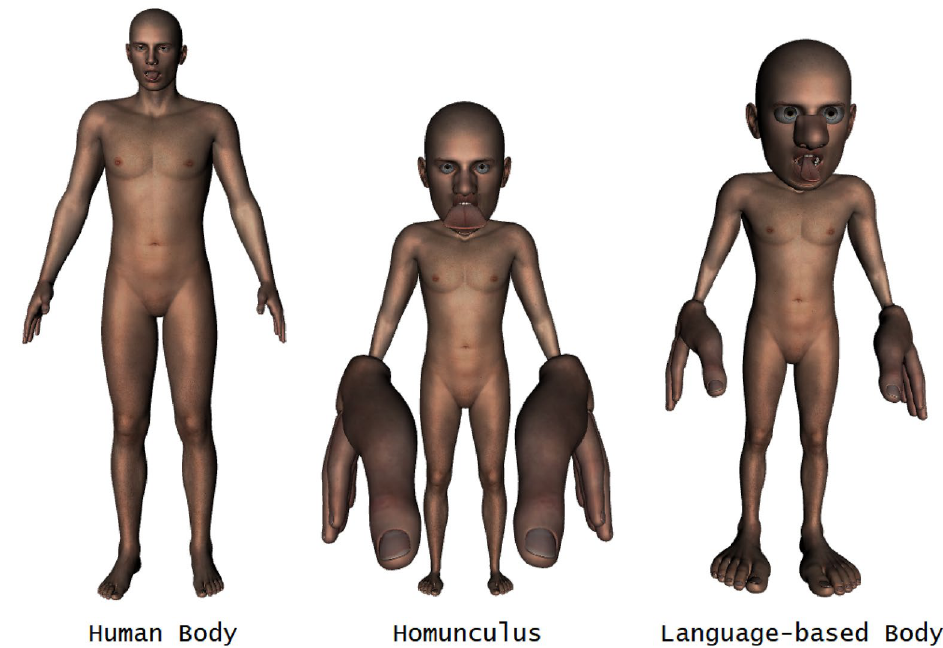
Figure 4. Left Actual human body proportions. Middle Sensory representational size proportions (i.e., the sensory homunculus (1)). Right Word frequency proportions. These figures were created by computing the relative (distorted) surface area of each body part for stimulations (Homunculus) and word frequencies (Language-based body), and mapping them on the “Genesis 2 Male” model in Daz 3D (https:// www. daz3d. com/). Yet, because the morphing software used is based on volume rather than on surface area, we further adjusted our computation to the different ratios of surface area to the volume of distinct body parts 42